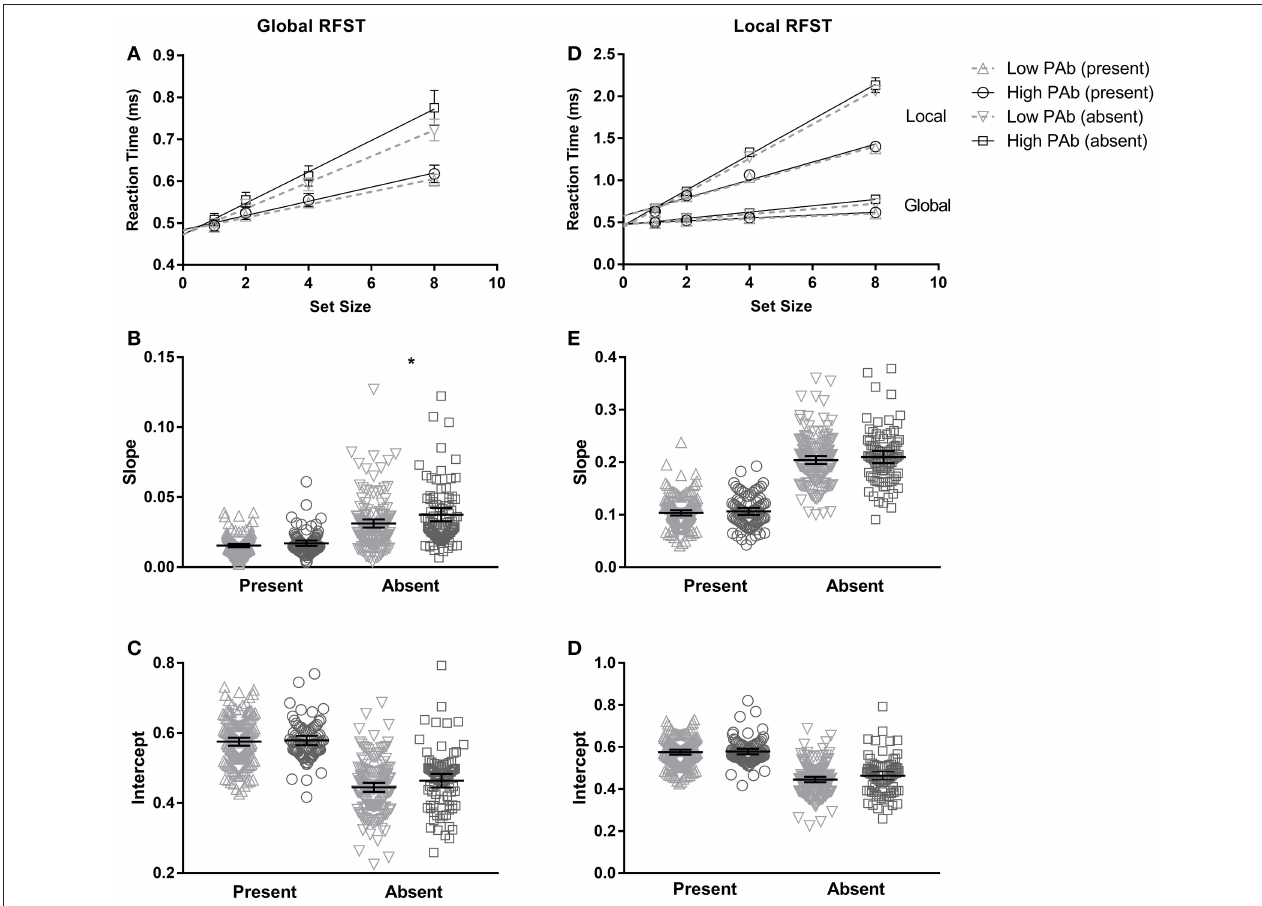
FIGURE 2 | Mean search slopes and intercepts for the High and Low PAb groups for the Global (left panels) and Local (right panels) RFSTs, derived by fitting a linear function when reaction time is plotted against set size (see A , D ). Due to differences in task difficulty between Global and Local, the data are presented on different axes. (D) Highlights the difference in task difficulty between Global and Local RFST’s, when they are shown on the same axes. Individual slopes (B,E) and intercepts (C,F) are represented in the bottom panels. The High PAb group exhibited significantly steeper search slopes for the Global Absent RFST only (* p is significant at the 0.05 level,